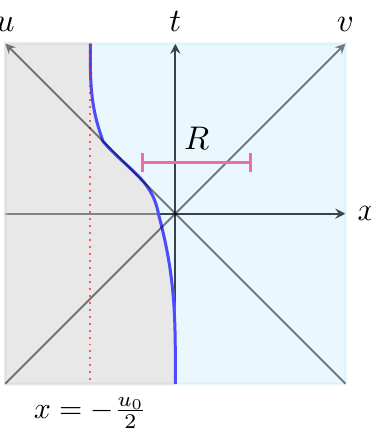
Figure 9 . The mirror trajectory describing an evaporating black hole (3.22). It starts from x = 0 , approaches to the light-ray t = − x around the time interval t = [0 , u 0 / 2] , then asymptotes to x = − u 0 / 2 at late time. The region probing the entropy and capacity of entanglement is located at R = [ z ( t ) + 0 . 1 , z ( t ) + 10] .